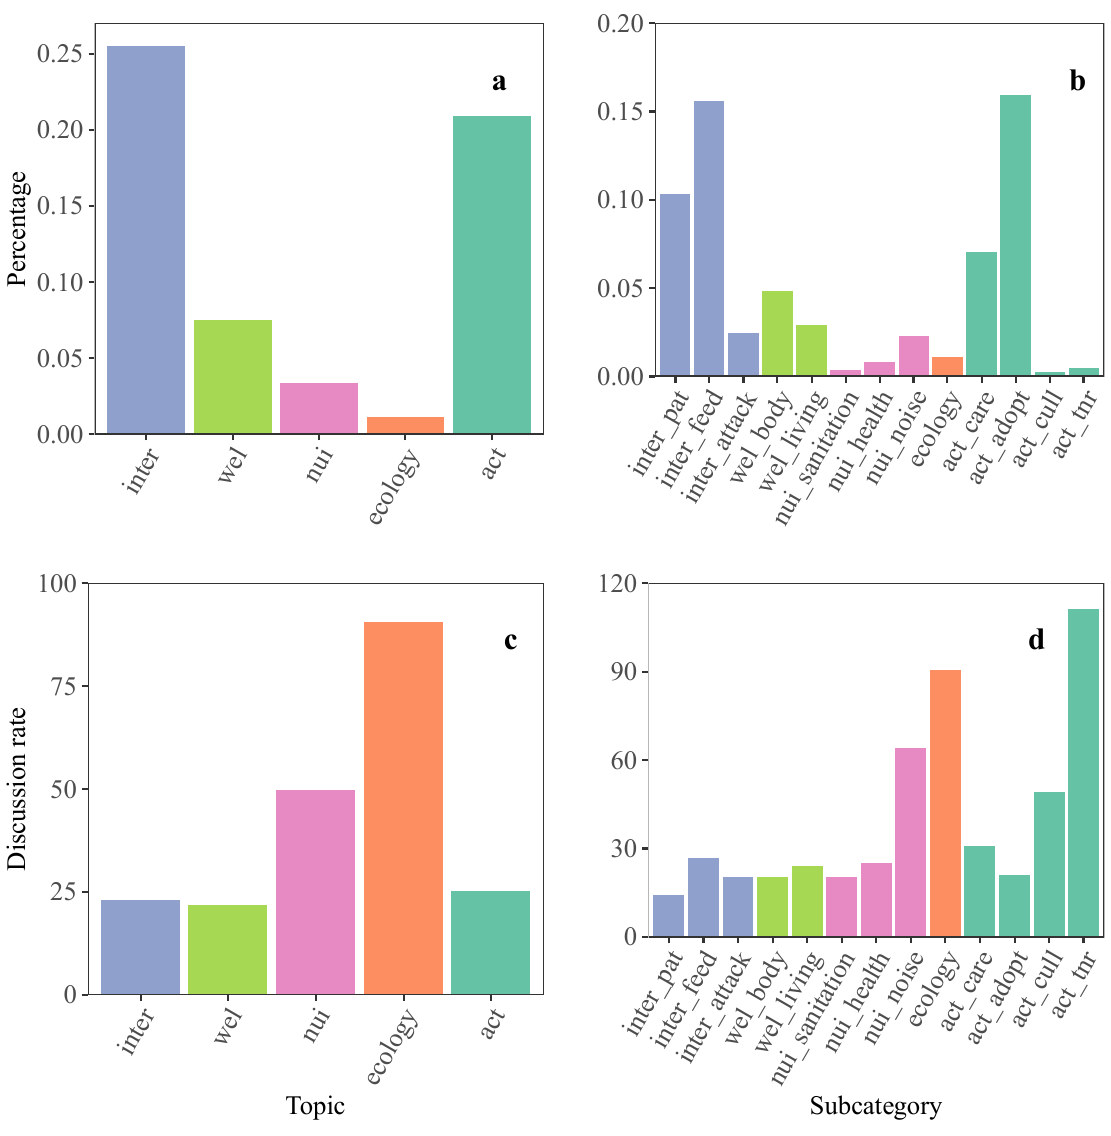
Figure 2. The percentage and discussion rate of identified topics. ( a ) The topics of human-stray cat interactions and actions to be taken for stray cat management took the largest percentage in public discussion. ( b )The subcategories “Stray cat adoptions”, “Humans get close to stray cats”, and “Humans give food to stray cats” took the largest percentage in public discussion. ( c ) The topics “ecological impacts” and “public nuisances” had the highest discussion rate. ( d ) The subcategories “To take the TNR method for managing stray cat population”, “The ecological impacts”, and “Stray cats making noise” had the highest discussion